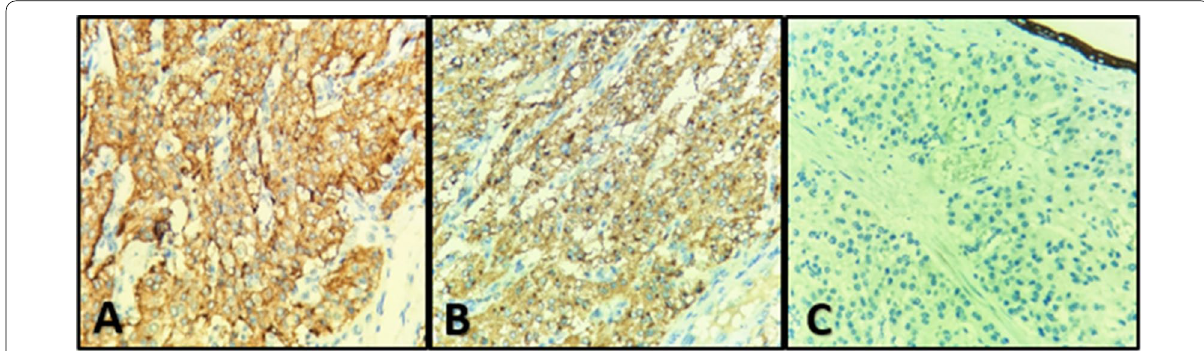
Fig. 7 Diffuse intracytoplasmic positivity (brown staining) in tumor cells for synaptophysin ( A ) and chromogranin ( B ) and negative staining (blue) for cytokeratin ( C ). Immunohistochemistry